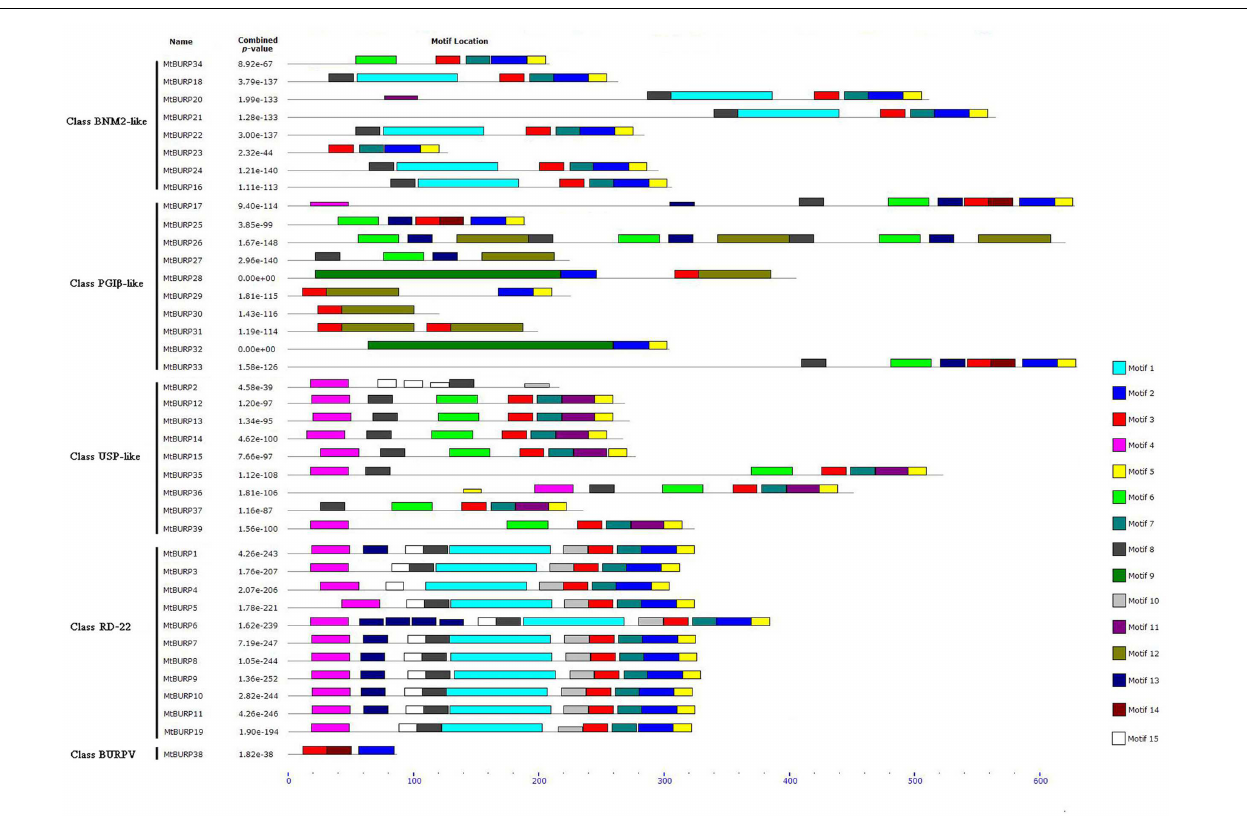
FIGURE 5 | The 15 putative motifs identified in the Medicago truncatula BURPs by multiple expectation maximization for motif elicitation (MEME). Different motifs are indicated by different colors and shown on the right. Names of all members and P -value are shown on the left. Among the 15 conserved motifs, nine are BURP motifs (i.e., motif 1, 2, 3, 5, 6, 8, 9, 11, and 12). Other motifs with unknown functions were also found; perhaps these motifs are required for specific protein